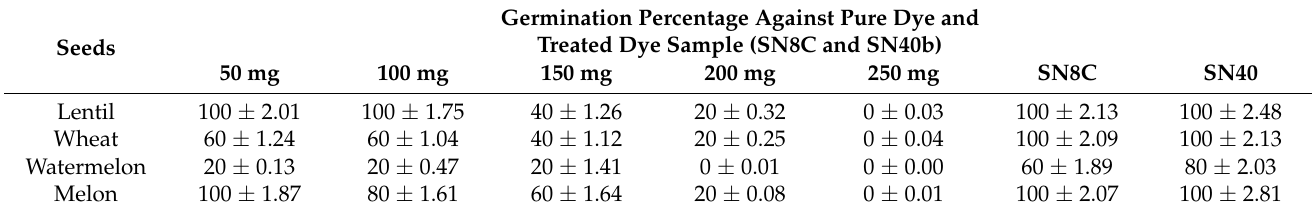
Table 2. Seed germination inhibition activity.